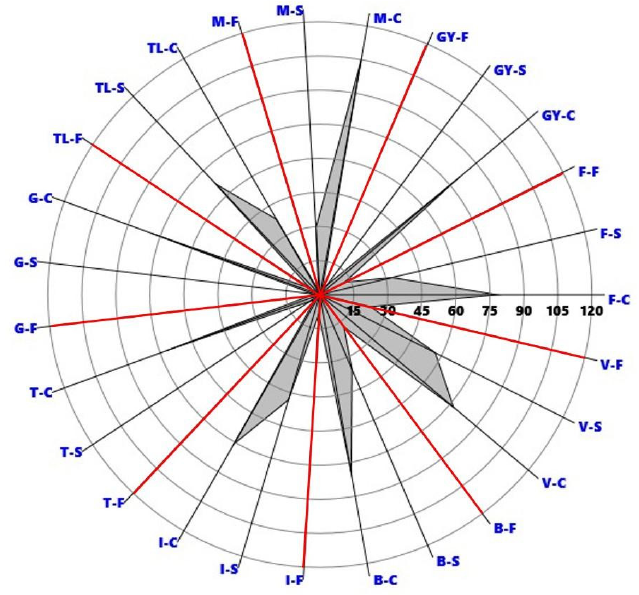
Figure 3. Polar diagram of Ailanthus altissima cover % per study site and forest layer: C—canopy layer; S—shrub layer; F—forest floor layer; for the abbreviations of the study sites see Figure 1.